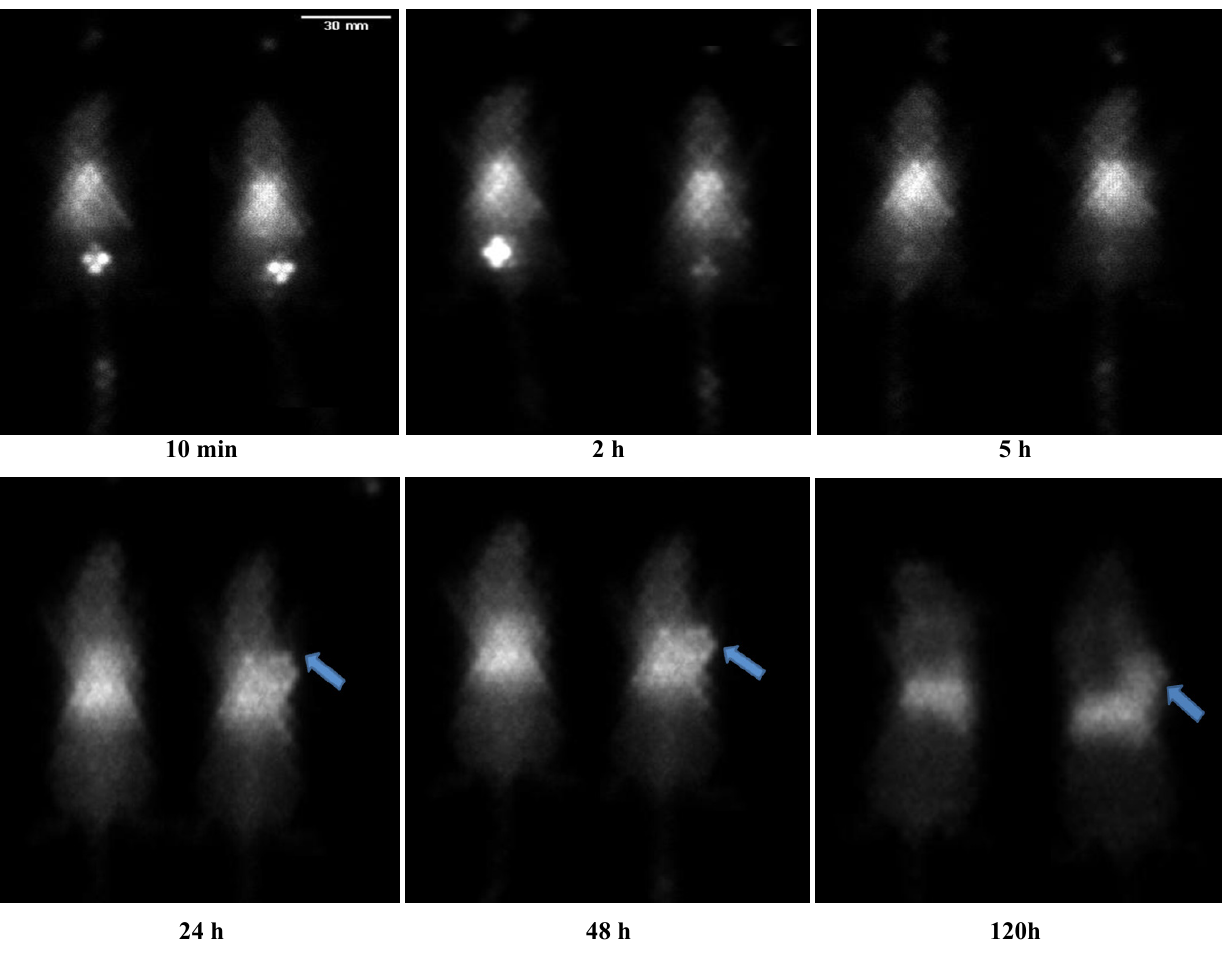
Figure 6. Representative gamma images of A 431 bearing nude mice at various times